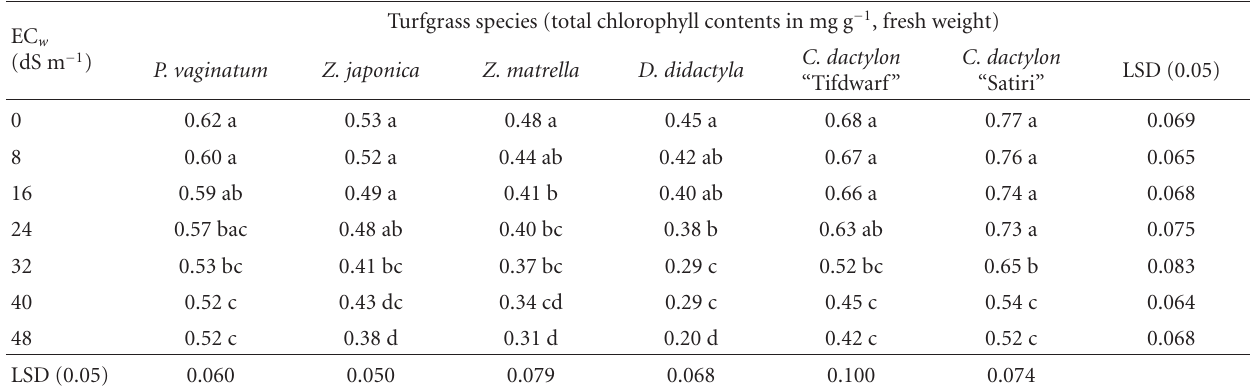
Table 8: E ff ect of salinity on total chlorophyll concentration of six turfgrass species. EC